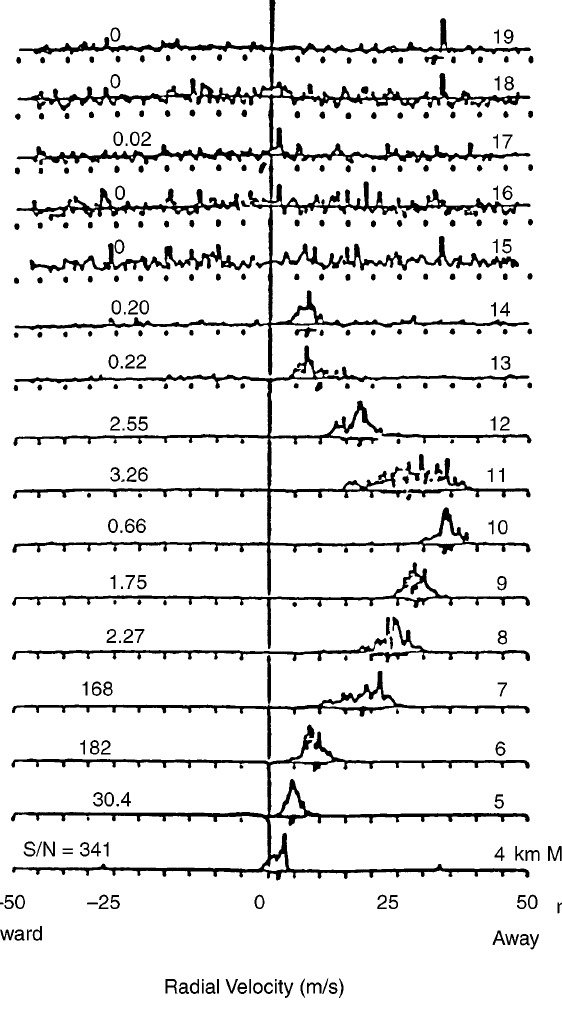
Fig. 3. Radial velocity versus altitude measured by the Sunset radar on 15 April, 1976, at 1606 105 (cid:176) W time, with the beam pointed at 30 (cid:176) to the north (from Van Zandt et al ., 1978)